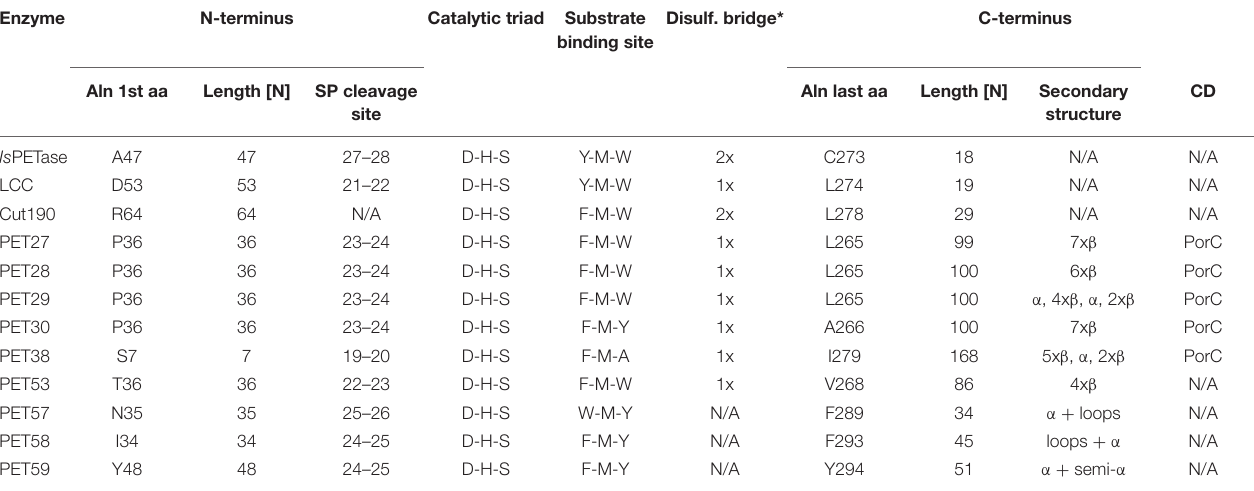
TABLE 3 | Conserved motifs and structural features identified in the predicted bacteroidetal PET-hydrolyzing esterases. Enzyme N-terminus Catalytic triad Substrate